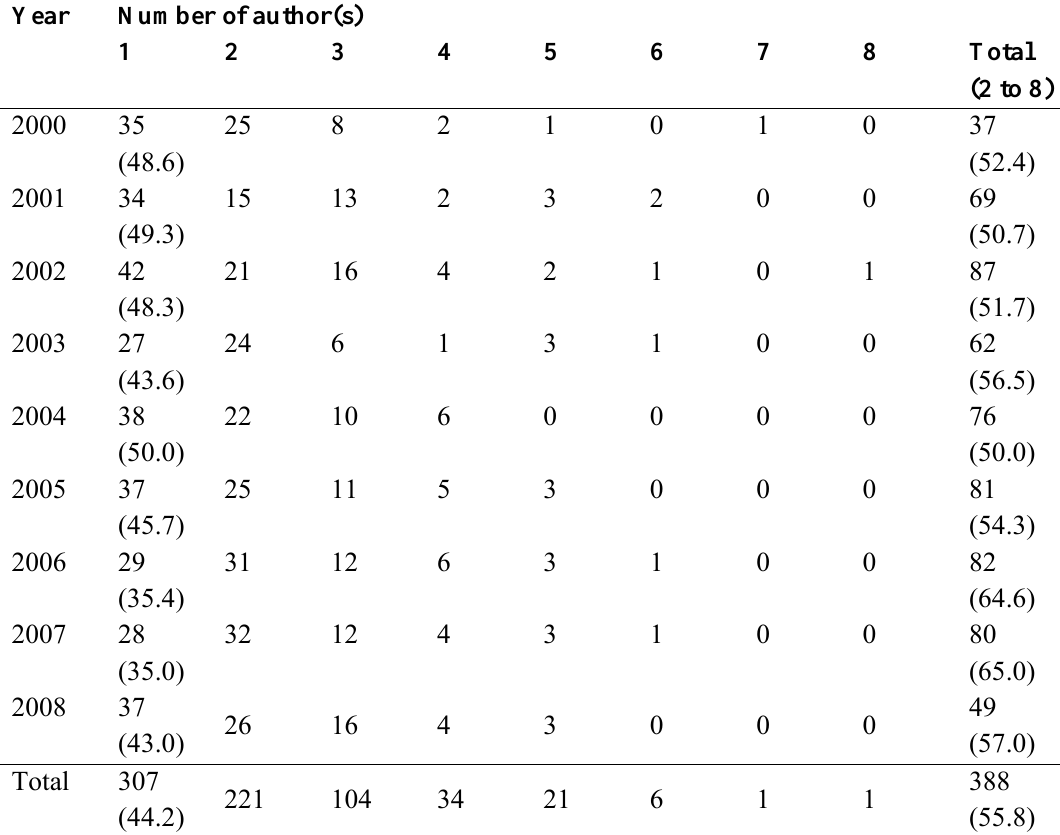
Frequency Tabulation Regarding the Number of Authors by Year (Percentages in